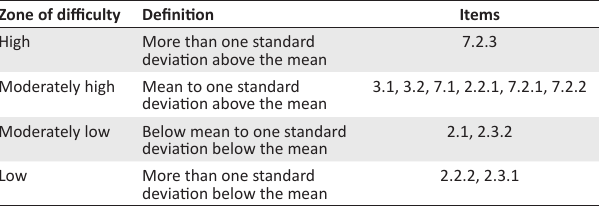
TABLE 3: Clustering of items in zones of difficulty.